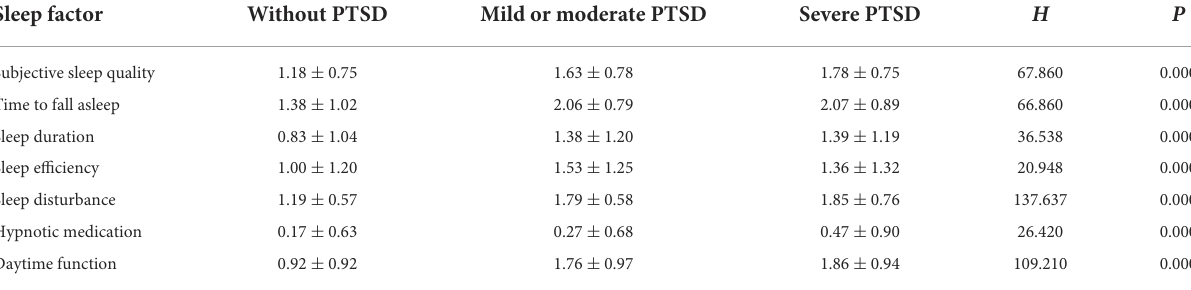
TABLE 5 Comparison of sleep quality between elderly adults with varying degrees of PTSD in different dimensions (points, ¯ X ± S ). Sleep